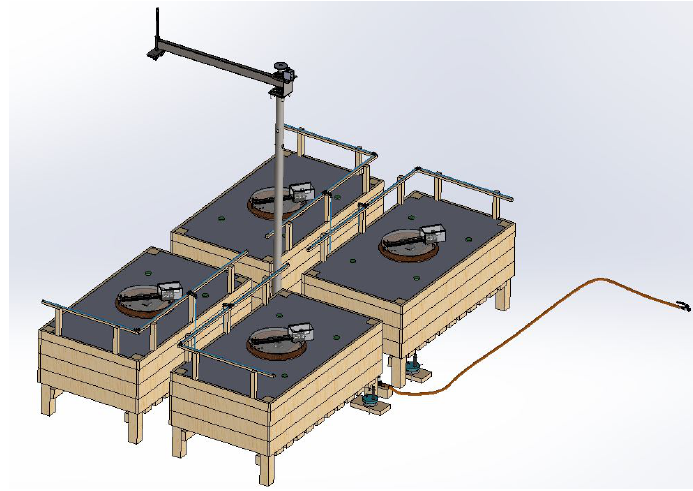
Figure 3. Final 3D CAD of the data collection system’s physical part.